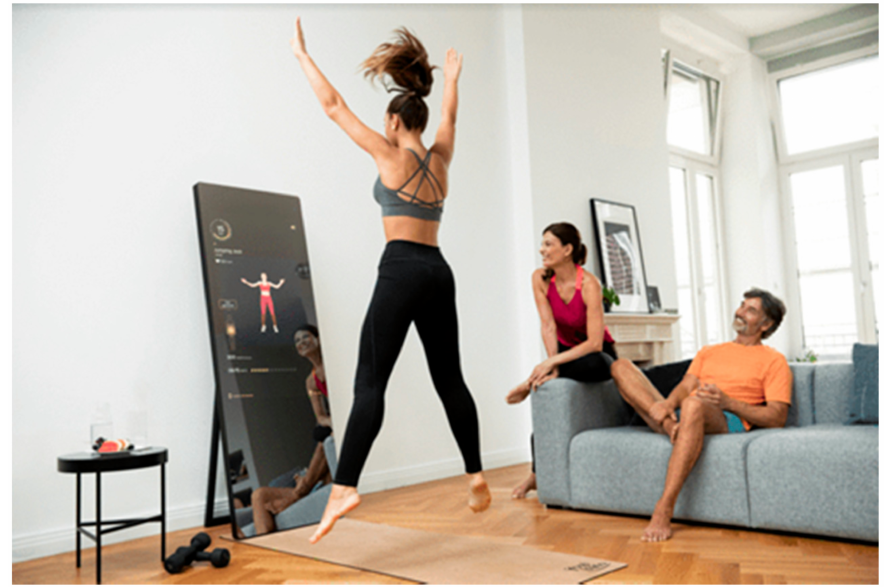
Figure 2. Vaha Fitness Mirror (Source: Vaha).